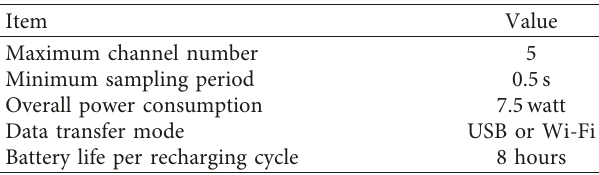
Table 1: Main parameters of the MWD system.